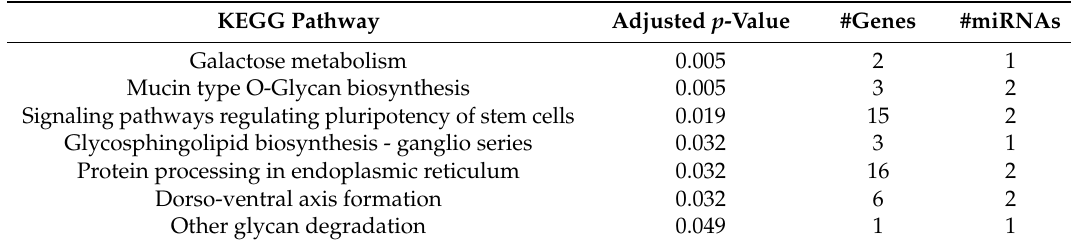
Table 4. Enrichment pathways of predicted target genes of two key exosomal miRNAs for Budesonide treatment. KEGG Pathway Adjusted p -Value #Genes #miRNAs Galactose metabolism 0.005 2 1 Mucin type O-Glycan biosynthesis 0.005 3 2 Signaling pathways regulating pluripotency of stem cells 0.019 15 2 Glycosphingolipid biosynthesis - ganglio series 0.032 3 1 Protein processing in endoplasmic reticulum 0.032 16 2 Dorso-ventral axis formation 0.032 6 2 Other glycan degradation